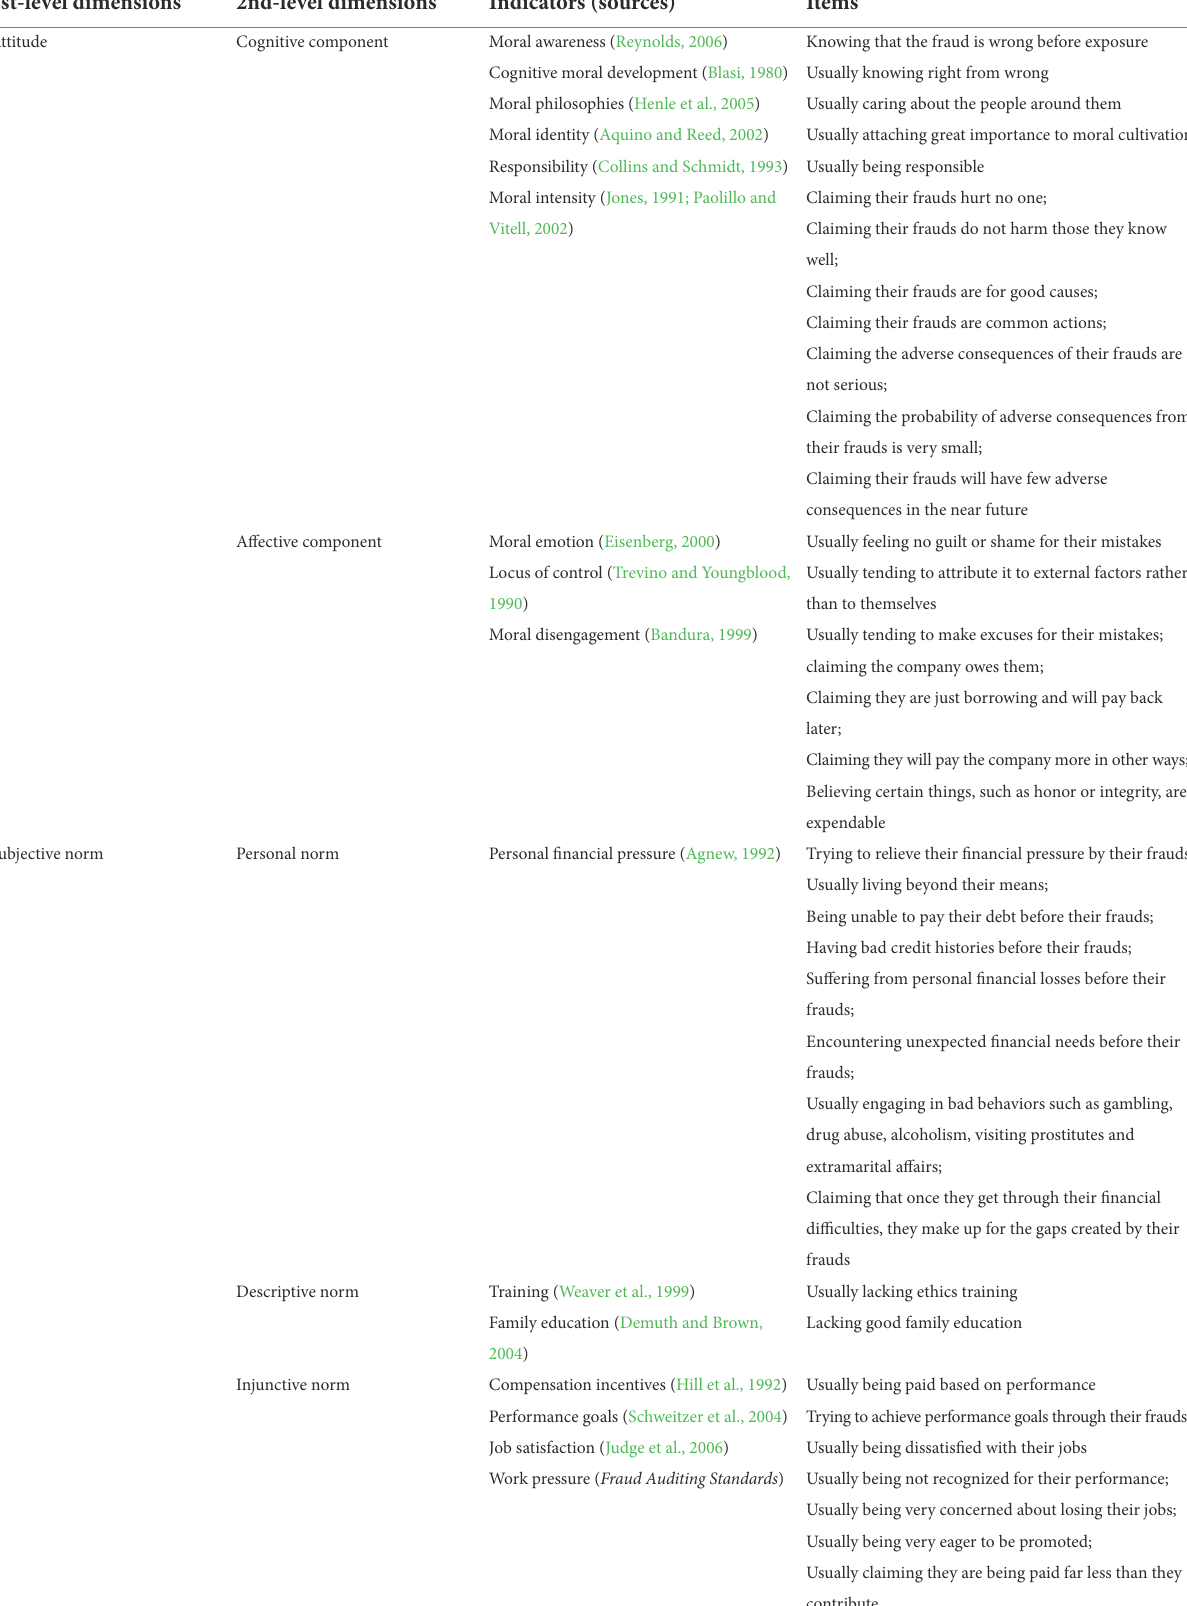
TABLE 3 The primary items of scale of employee fraud